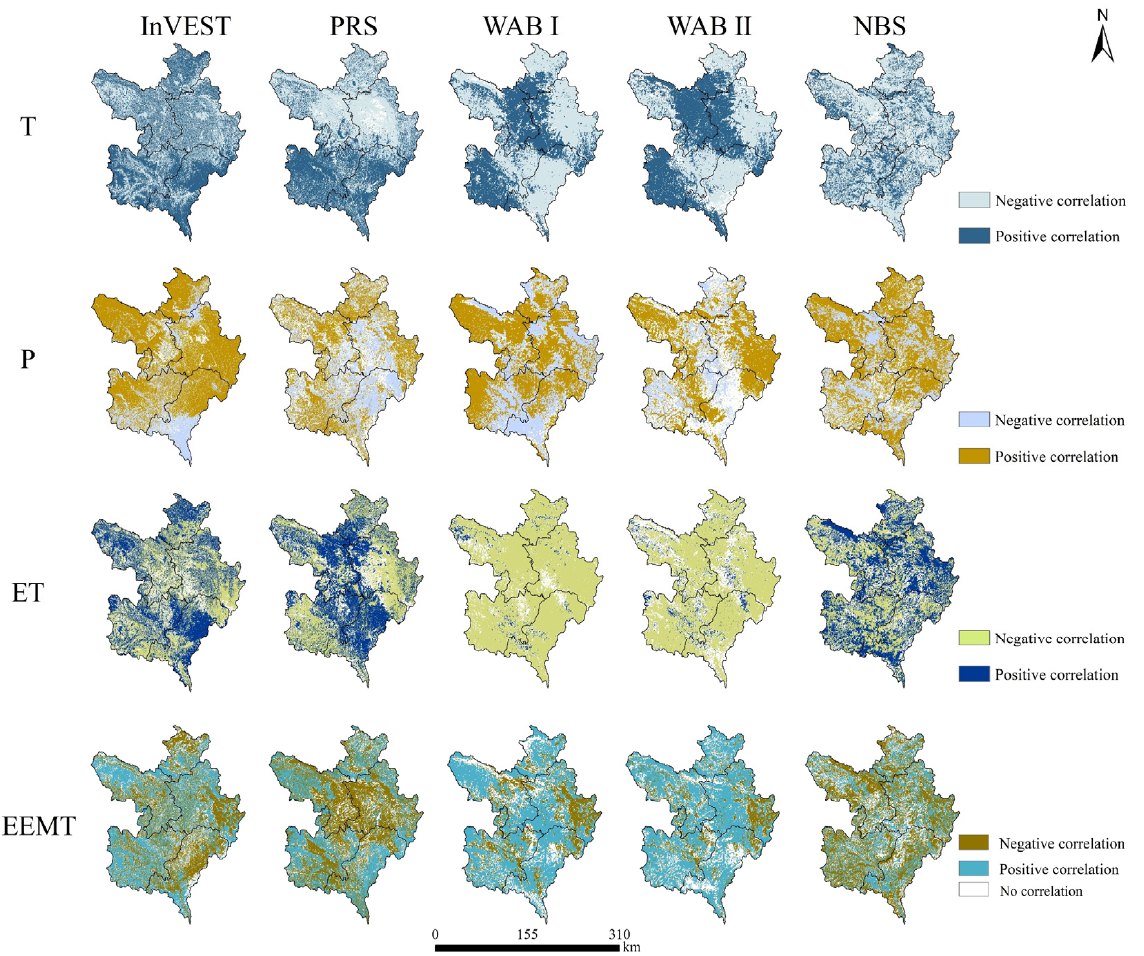
Figure 8. Distribution of partial correlation between natural drivers and WR service by five models ( p < 0.05). T: temperature, P: precipitation, ET: evapotranspiration, EEMT: effective energy and mass transfer. Table 3. Area and percentage of positive and negative correlations between water retention and drivers.